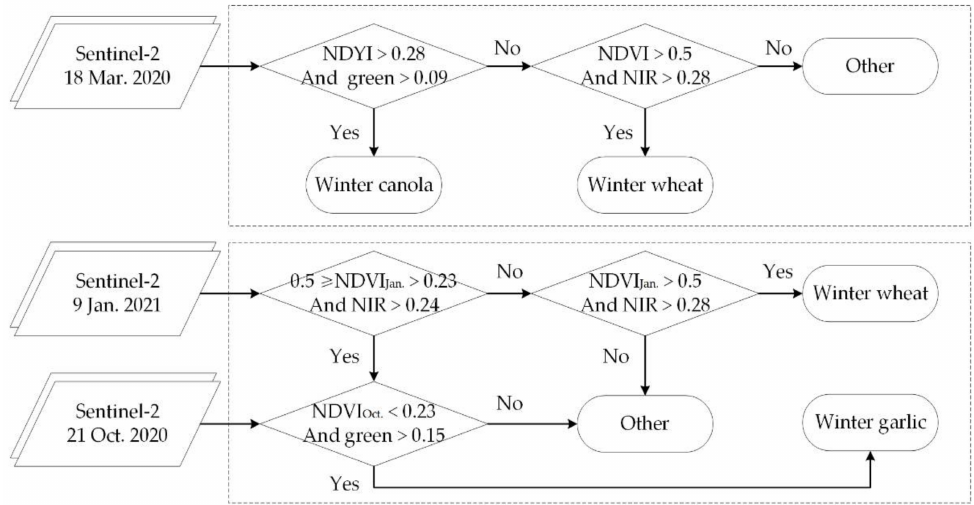
Figure 4. Decision tree model for classification of different types of winter crops.